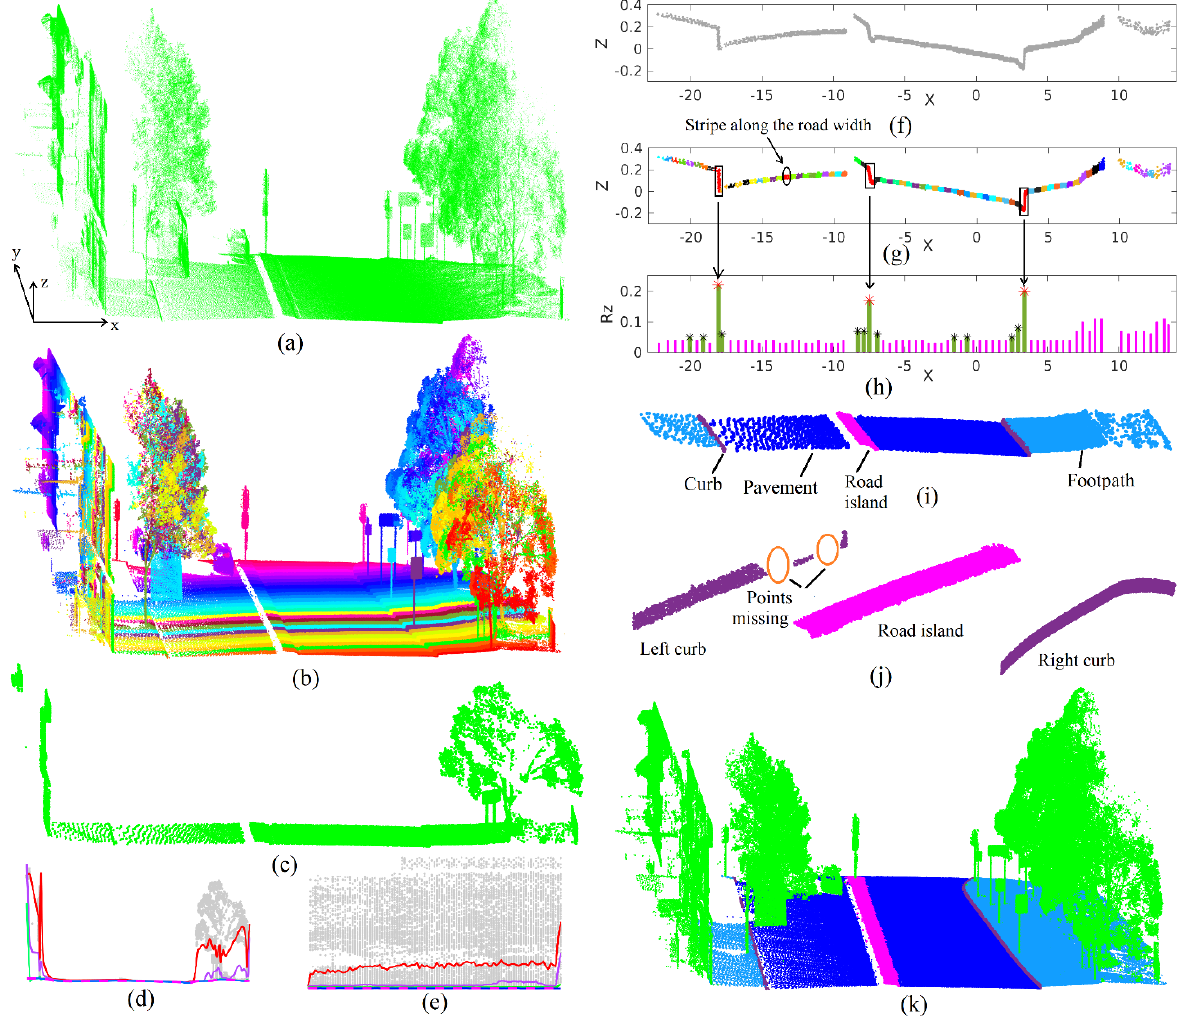
Figure 4. Road surface extraction, Experiment 2: (a) road point cloud, (b) different stripes in different colors, (c) one stripe along the road length, (d) iterative fitting for ground on x-z profile, (e) iterative fitting for ground on y-z profile, (f) ground surface points for plot (c), (g) patches along the road width, (h) bar diagram for the 𝑅 𝑧 values for the patches of plot (g), (i) classified road surface points for plot (c), (j) extracted curbs and road island, two ellipses indicate missing points due to the presence of vehicles on the road (a), and (k) classified road and non-ground surfaces for the full data set in